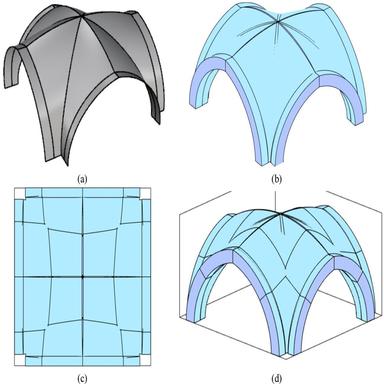
NURBS model in Rhinoceros® (a) and imported in MATLAB® (b) where limit analyses are carried out. (c)–(d): plane and perspective view of the initial mesh utilized.